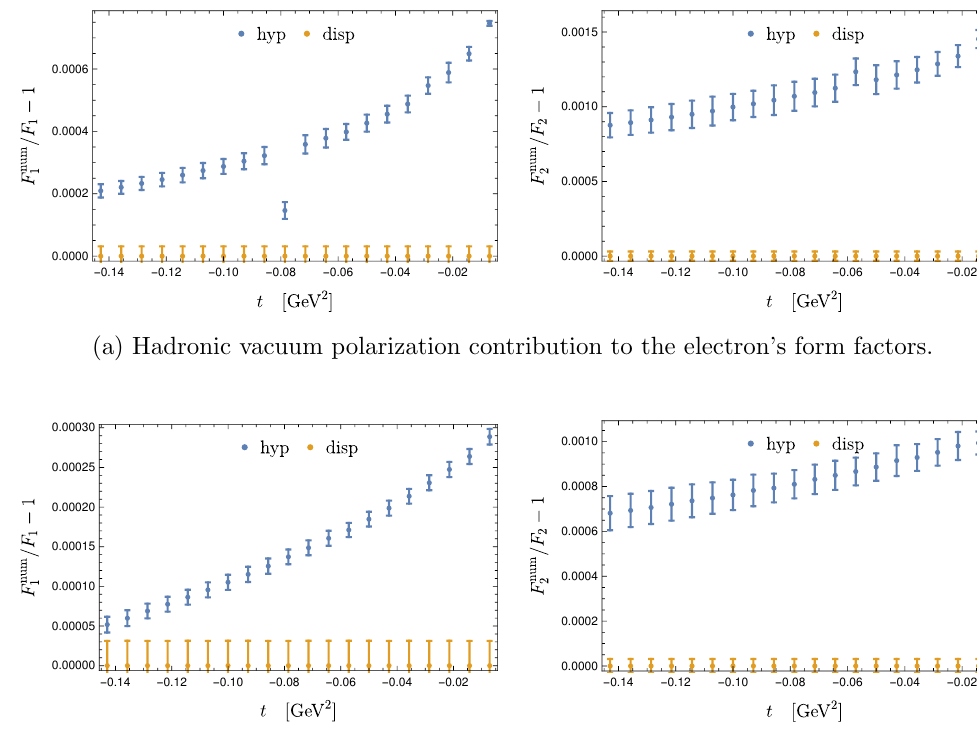
Figure 6. Hadronic vacuum polarization contribution to the form factors for p s = 0 : 405 GeV and t 0 : 142 Gev 2 0 GeV 2 . Relative di(cid:11)erence between the values obtained with the hyperspherical (cid:0) (cid:20) (cid:20) and the dispersive method. The result given by the dispersive method is used as normalization factor. The error bars show the uncertainty due to the numerical